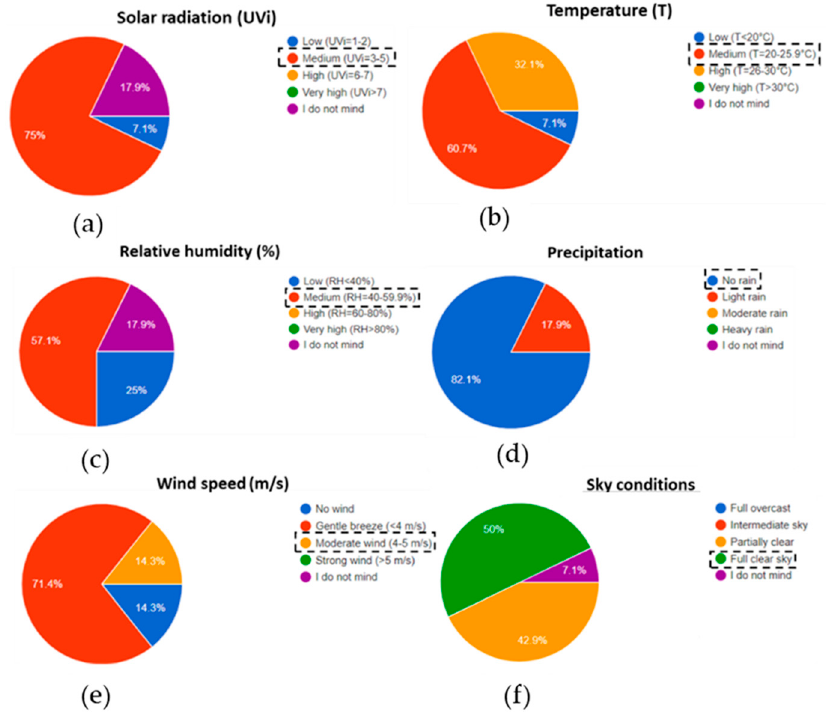
Figure 11. Preferred levels of weather conditions according to survey participants: solar radiation in terms of UV-index (UVi) ( a ), outdoor dry bulb temperature (T) ( b ), relative humidity (%) ( c ), precipitation ( d ), wind speed (m/s) ( e ), and sky condition ( f ). The classes used in these survey questions were designed according to interviews’ answers (Section 3.1).